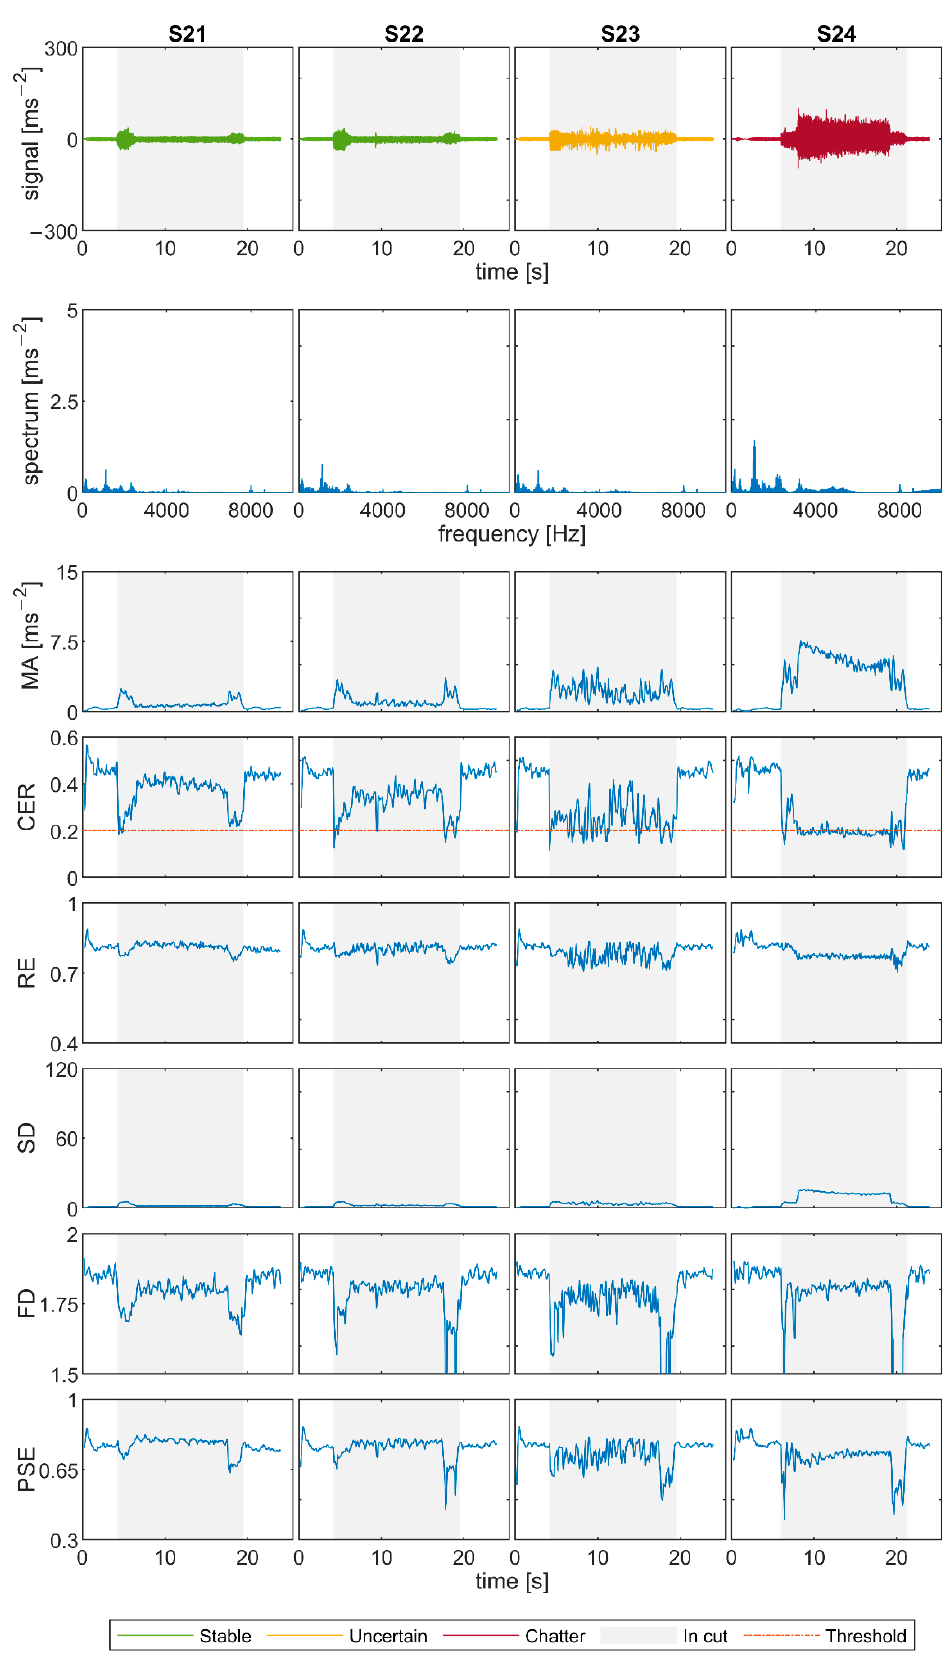
Figure A5. Signals from Experiment 3—shoulder mill.